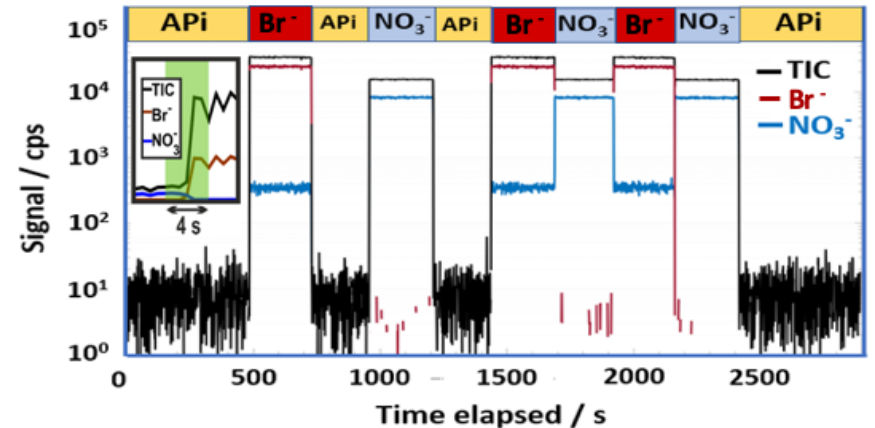
Figure 2. An example of switching between multiple ion chemistries while sampling laboratory air. The ion modes utilized have been marked with separate colors and are further labeled above the figure with abbreviations: APi for ambient ion mode (no active ionization applied; black trace), Br − for bromide ion ionization mode (red trace), NO − for nitrate ion ionization mode (blue trace), and TIC is used to indicate total 3 ion count measured (black trace). The insert demonstrates the rapid ion mode switch, shown in a linear scale. All signals shown here were retrieved by high-resolution peak